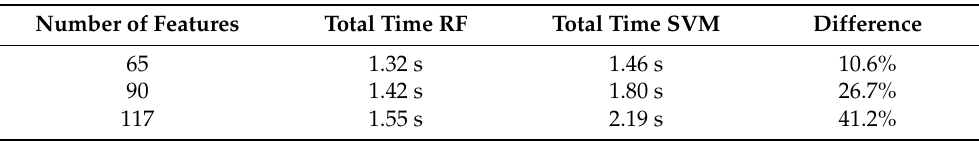
Table 6. Total RF and SVM (C = 1) execution times, including both training and implementation, as number of features increases (Sentinel-2 feature space).